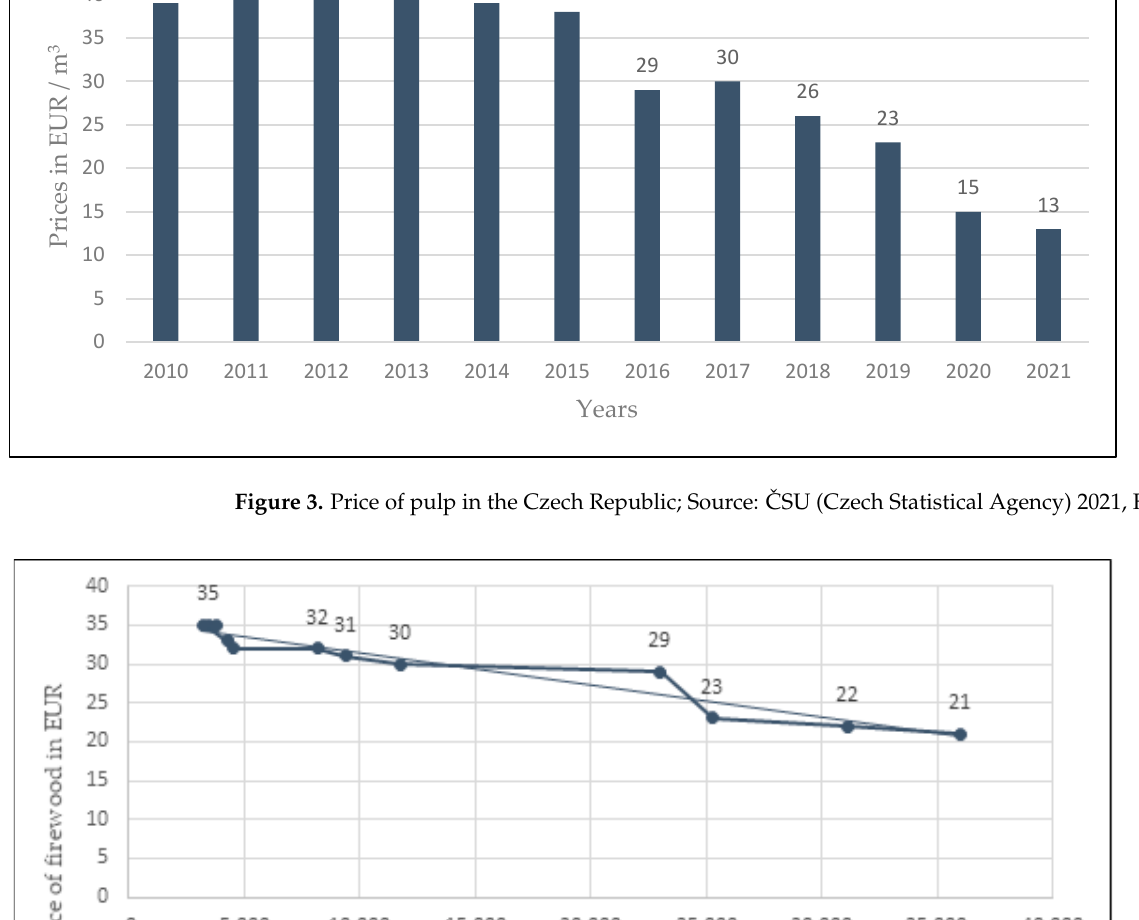
Figure 3. Price of pulp in the Czech Republic; Source: Č SU (Czech Statistical Agency) 2021, Forestry.